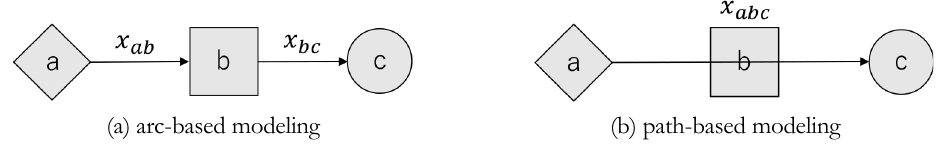
Figure 6. Arc-based modeling versus path-based